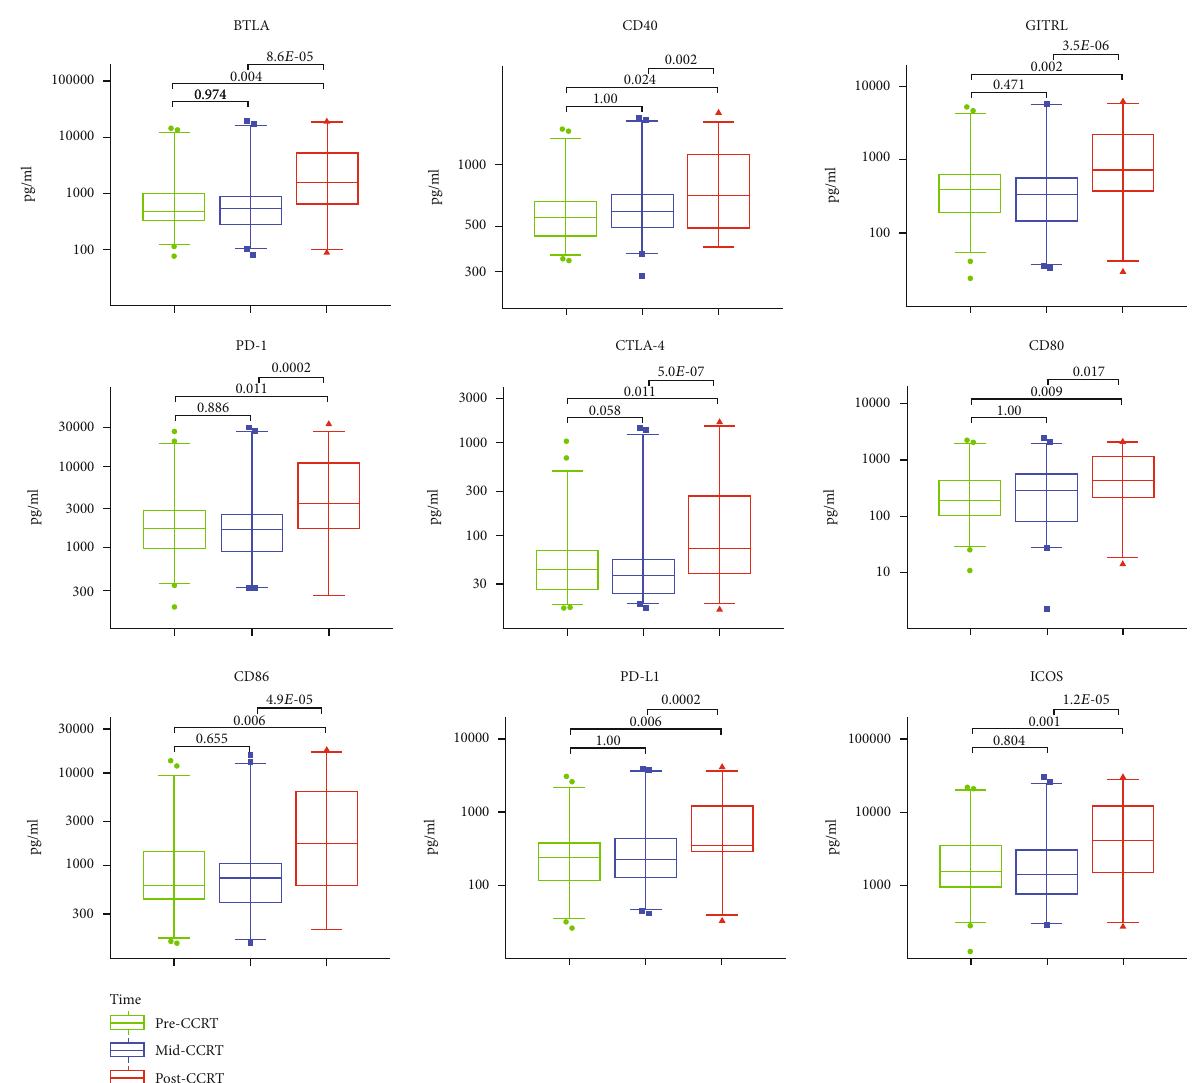
Figure 2: Signi fi cant changes in the sICPs after CCRT. The serum levels of BTLA, CD40, GITRL, PD-1, CTLA-4, CD80, CD86, PD-L1, and ICOS were compared among pre-CCRT (green), mid-CCRT (blue), and post-CCRT (red), showing signi fi cant changes after CCRT. P values were calculated using the Friedman test with Bonferroni ’ s